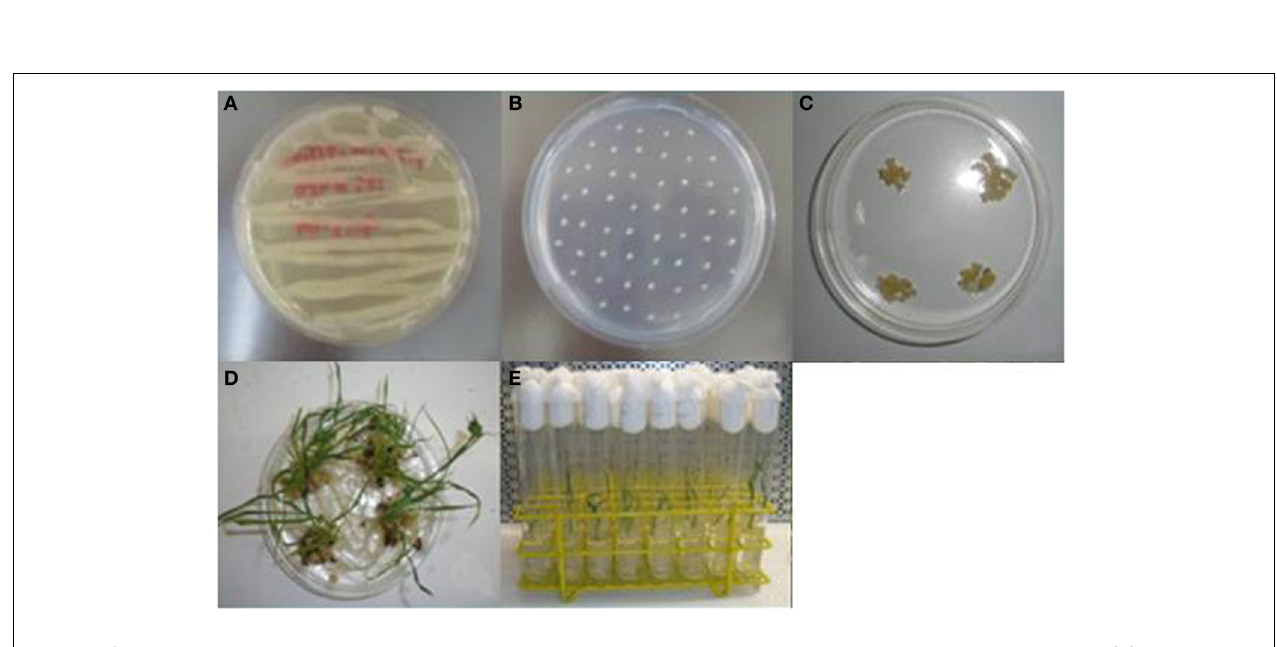
FIGURE 2 | Generation of transgenic rice plants by Agrobacterium -mediated transformation. (A) Growth of A. tumefaciens LBA4404 on AB medium; (B) co-cultivation of